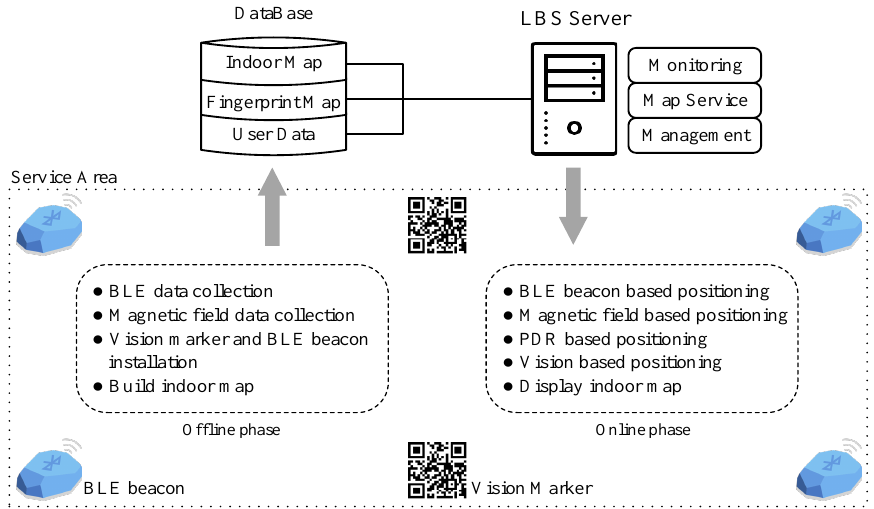
Figure 1. Operation procedure of the proposed indoor positioning